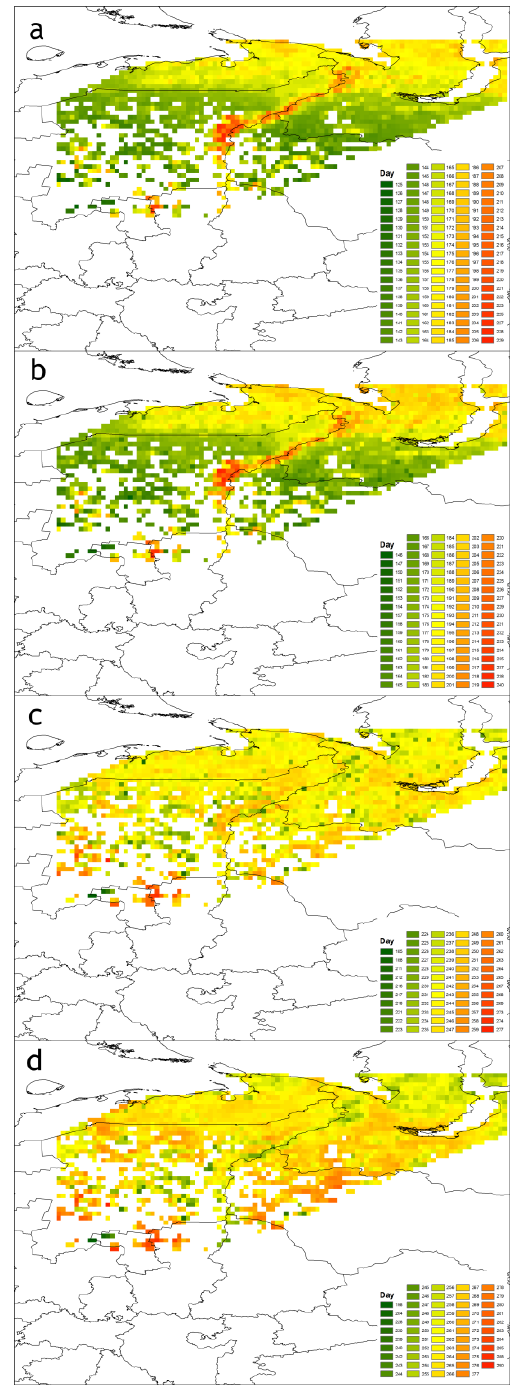
Figure 3. Maps of the average beginning dates of spring (a), summer (b) and autumn (c) growing seasons and of the ending dates of autumn growing season (d); legends are not aligned to highlight spatial